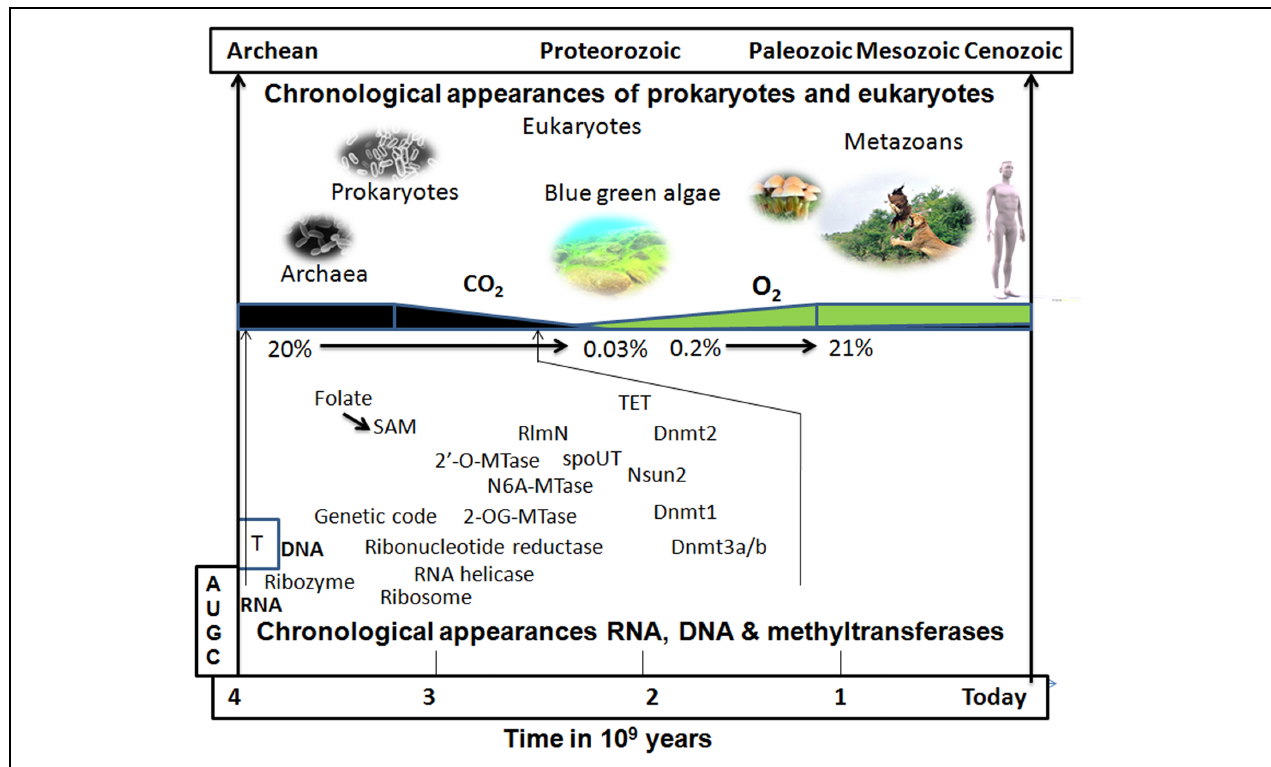
FIGURE 3 | Putative chronological appearance of RNA, DNA, MTases, prokaryotes, and eukaryotes. RNA, which functions as a genetic material, as a chaperone, and as a peptide synthesizer, is a likely candidate as the sole common precursor of other biomolecules de novo in the prebiotic world. RNA modification through snoRNA (RNA acting as a ribozyme) would have been the initial step to stabilize and protect RNA from the extreme environmental conditions of the prebiotic soup on Earth. An initial DNA-like molecule would have arisen from the non-enzymatic reduction of 2 (cid:2) -OH of ribose sugar rather than with ribonucleotide reductase which might have manifested after the appearance of the genetic code. The kingdom of prokaryotes and Archaea that arose on early Earth already possessed RNA, DNA, and their modifying enzymes in the course of evolution. There were many RNA MTases that were initially multi-specific, i.e., acting on many RNA species and some of them, later on, may have evolved to act on DNA. With the appearance of cyanobacteria (blue–green algae), the atmospheric CO 2 of the reducing Earth started to be consumed and its concentration gradually decreased while the concentration of O 2 started to build up (leading to the oxidizing atmosphere of the present-day Earth). Many enzymes shifted their mechanism of methylation away from depending on radical SAM (an anaerobic type of methylation; Zhang et al., 2011) to nucleophilic attack (S N 2 type) and evolved to become oxygen tolerant. The presence of oxygen may have triggered the reversibility of methylation reaction since demethylases (TET1-3) are often dioxygenases (Tsukada,